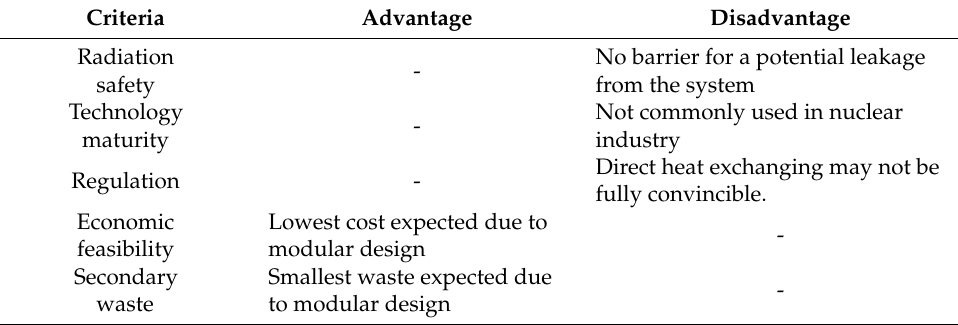
Table 15. Evaluation summary of modular direct heat exchange